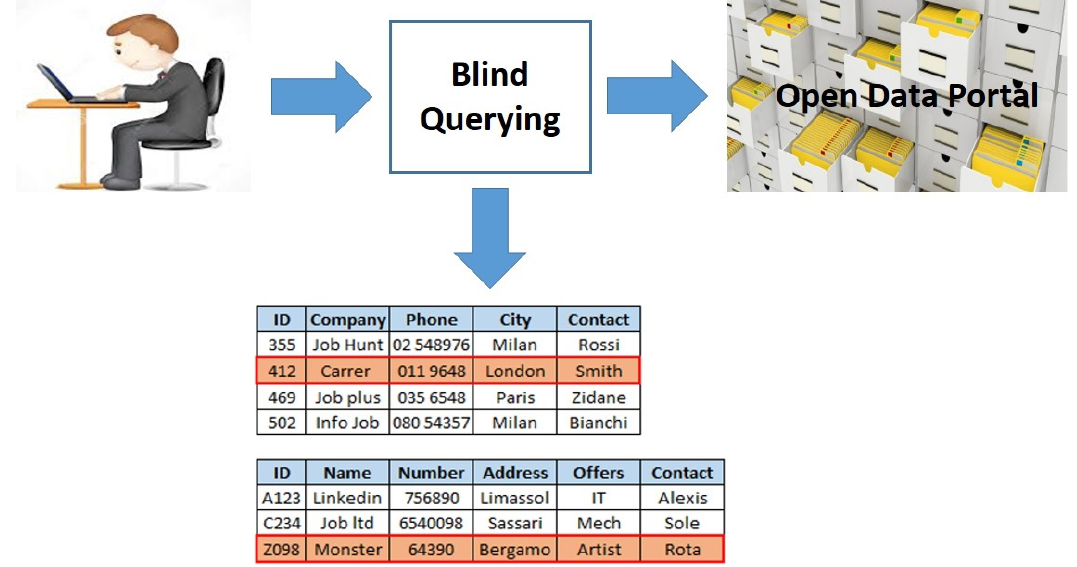
Figure 1. Blind querying